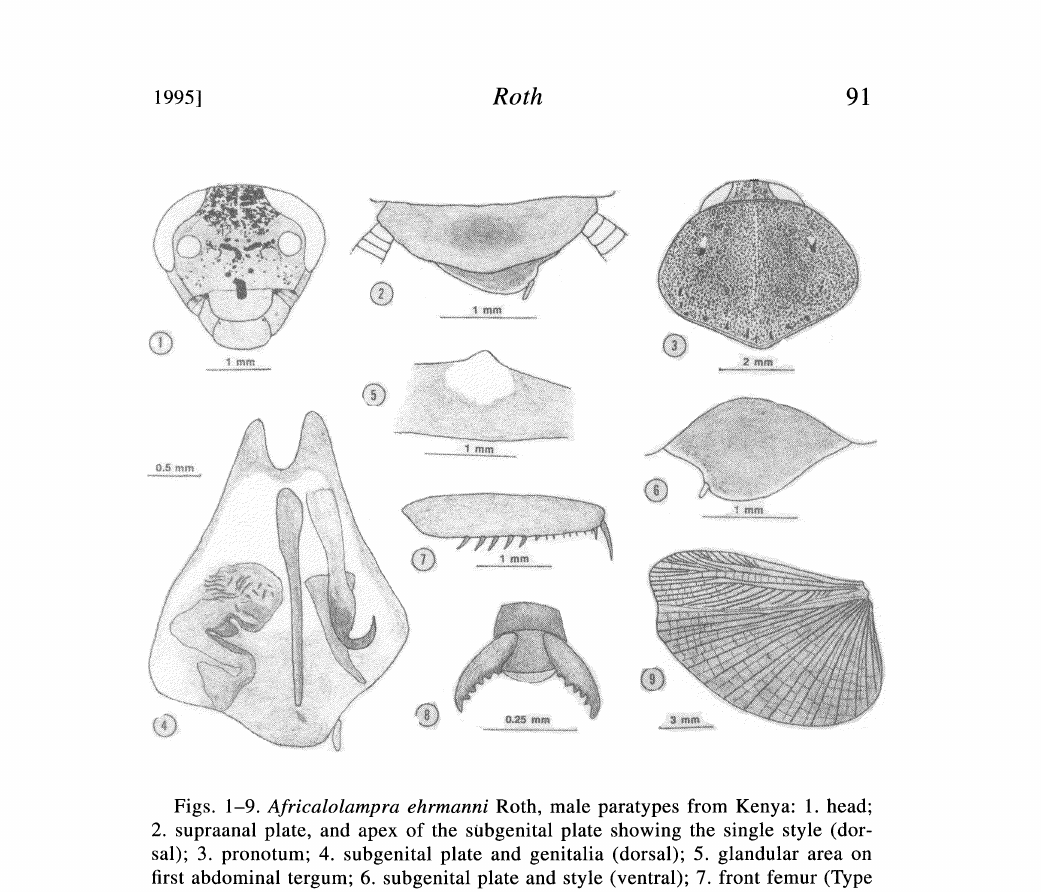
Figs. 1-9. Africalolampra ehrmanni Roth, male paratypes from Kenya: 1. head; 2. supraanal plate, and apex of the stbgenital plate showing the single style (dor- sal); 3. pronotum; 4. subgenital plate and genitalia (dorsal); 5. glandular area on first abdominal tergum; 6. subgenital plate and style (ventral); 7. front femur (Type B anterior view); 8. serrated tarsal claws, and arolium; 9. hind wing.